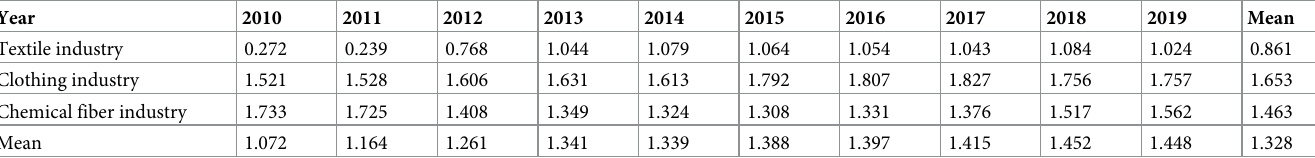
Table 5. SBM value of Super efficiency of textile and apparel industry from 2010 to 2019.